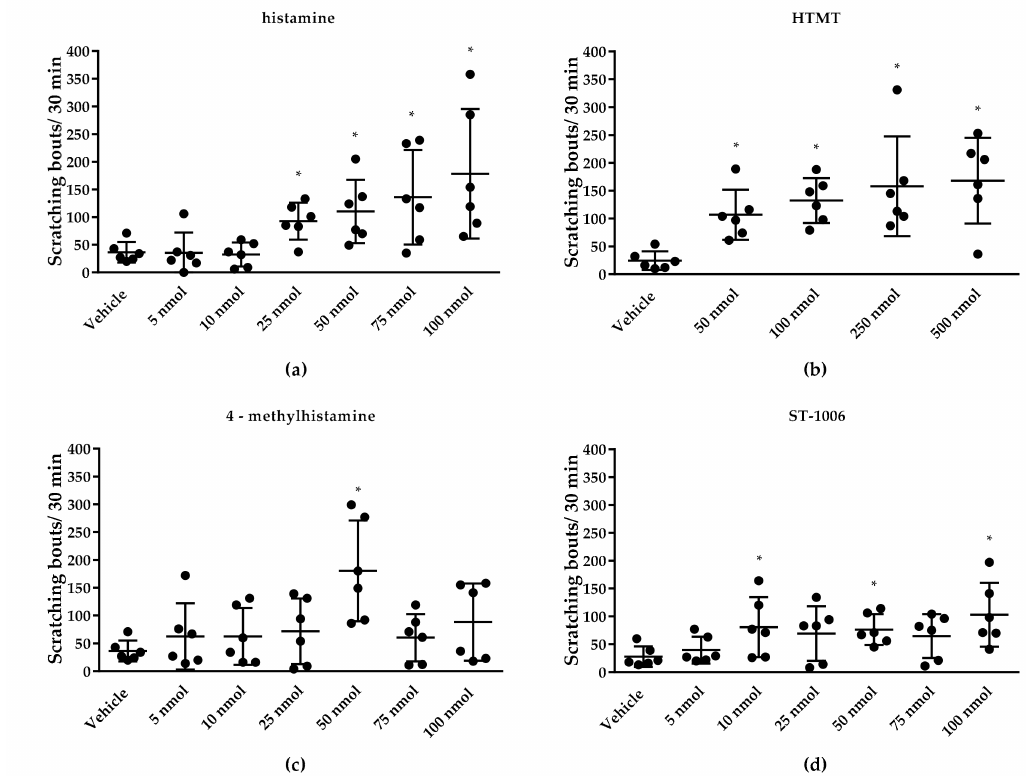
Figure 2. Concentration-dependent induction of itch by different histamine receptor agonists after intradermal application (50 µ L) in CD-1 mice. ( a ) Histamine (all HR) induced a significant scratching response at concentrations of 25–100 nmol/L. ( b ) HTMT (H1R/H2R) induced a significant scratching response at 50–500 nmol/L. ( c ) 4-MH (H2R/H4R) induced a significant scratching response at 50 nmol/L. ( d ) ST-1006 (H4R) induced a significant scratching response at 10, 50 and 100 nmol/L. * p < 0.05 (Mann–Whitney U test) = significantly different from vehicle control (saline)